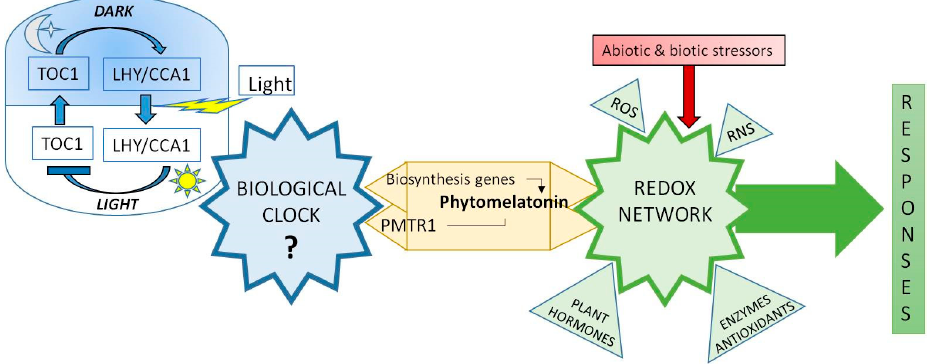
Figure 3. Possible relationship of the triad: core biological clock-Phytomelatonin-Redox network.